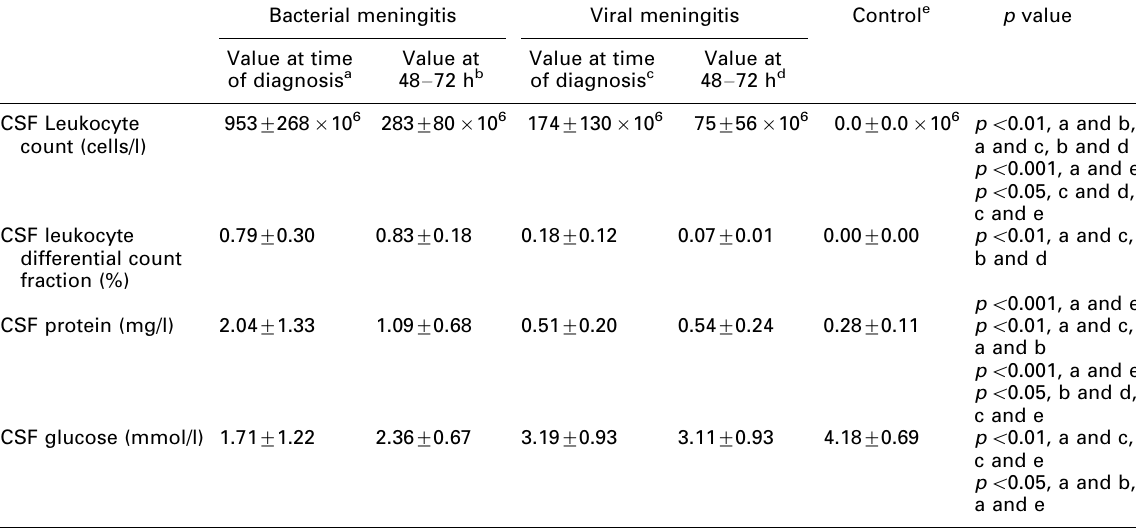
Table 2. Laboratory findings of all groups Bacterial meningitis Viral